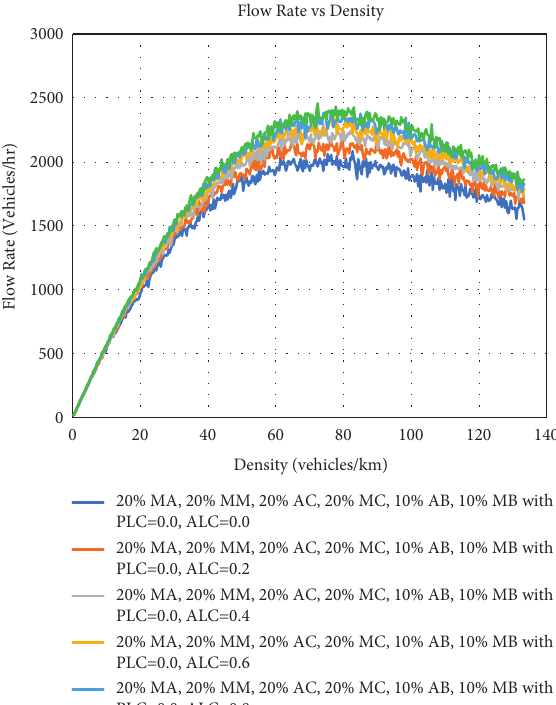
Figure 3: Speed vs. density fundamental diagrams for different compositions of MA, MM, AC, MC, AB, and MB with different values of ALC when PLC is fixed at